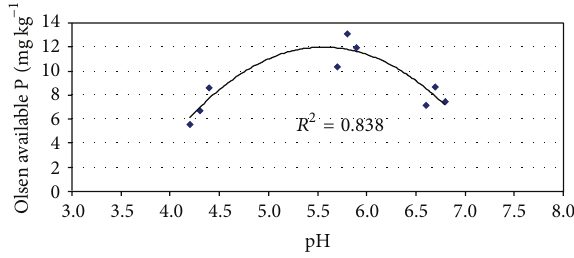
Figure 2: Relationship between average pH and average Olsen extractable